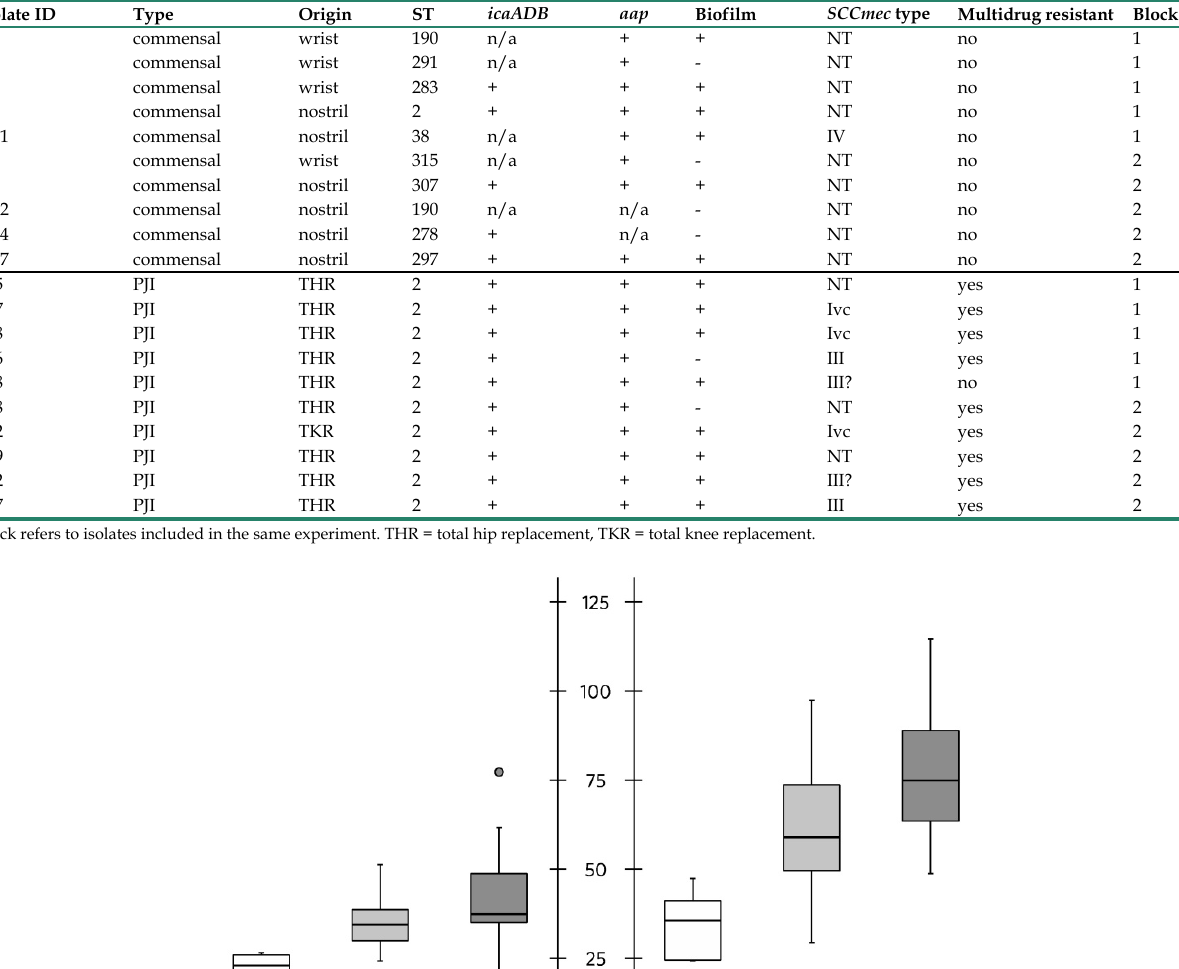
Table 1 . Isolate ID, type, origin, ST (sequence types), prevalence of virulence genes ( icaADB, aap ), biofilm production (phenotypic), SCCmec types, and multidrug resistance of S. epidermidis isolates (n=20). Isolate ID